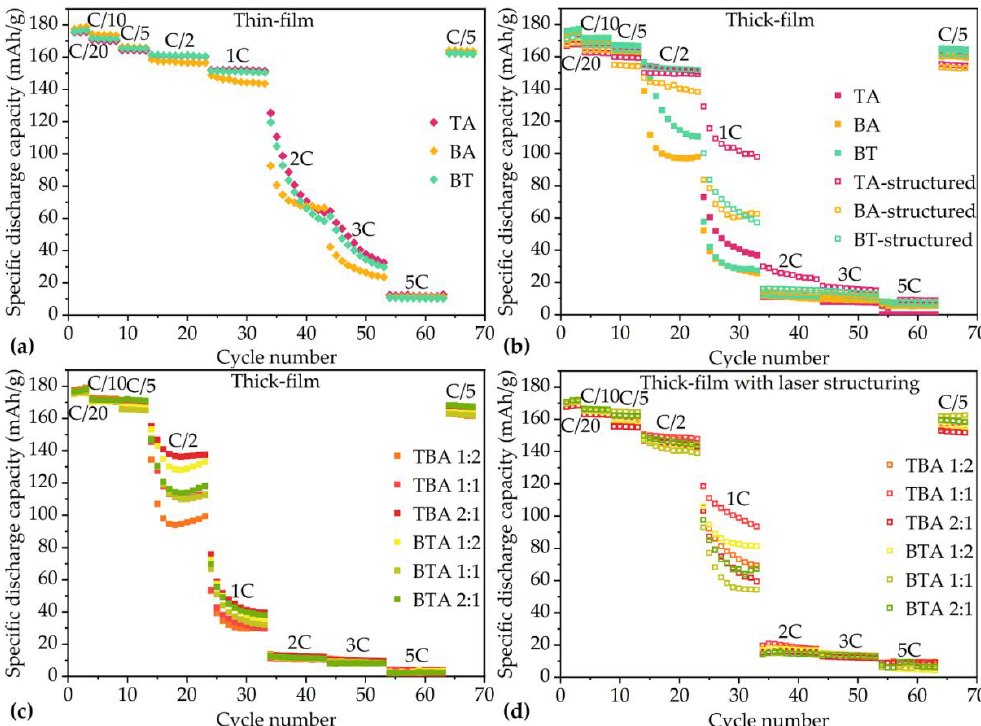
Figure 4. Rate capability tests of cells containing ( a ) thin-film electrodes with TA, BA, and BT. ( b ) Cells containing thick-film electrodes with TA, BA, and BT. Coin cells containing ( c ) unstructured thick-film multilayer electrodes and ( d ) structured multilayer thick-film electrodes.